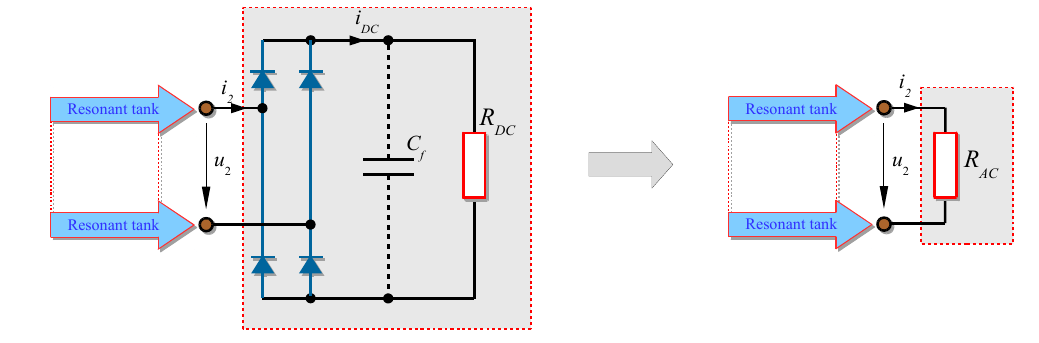
Figure 2. DC side load transformed into AC side load.